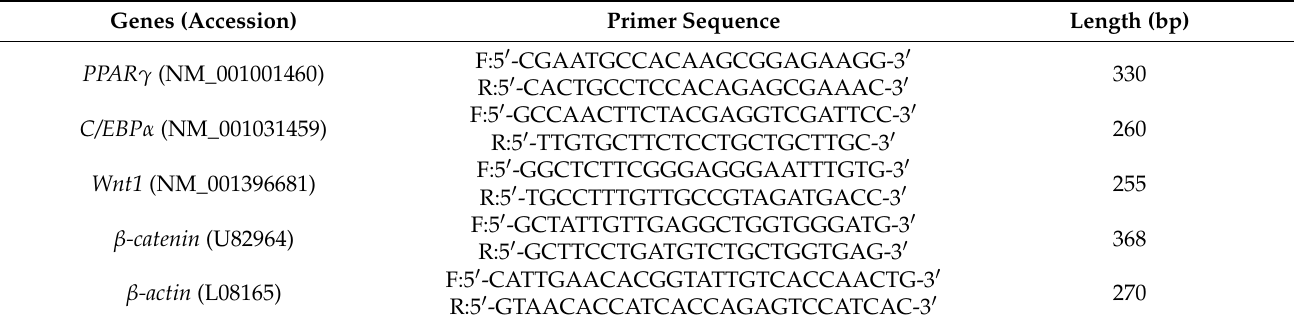
Table 2. Primer sequences for qRT-PCR